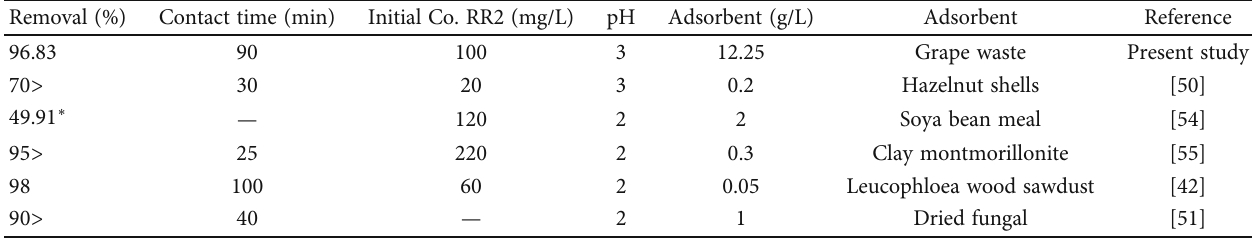
Table 4: The comparison of results of this study with previous